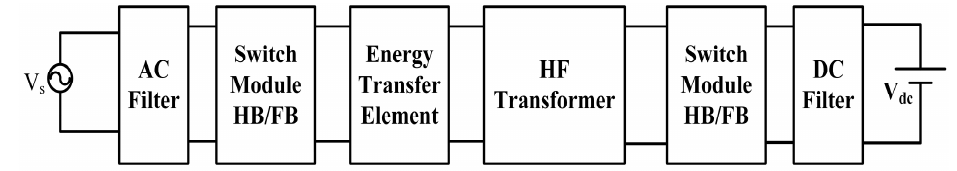
Figure 57. Low frequency AC-High frequency AC-DC converter, also called single-stage converter [113].